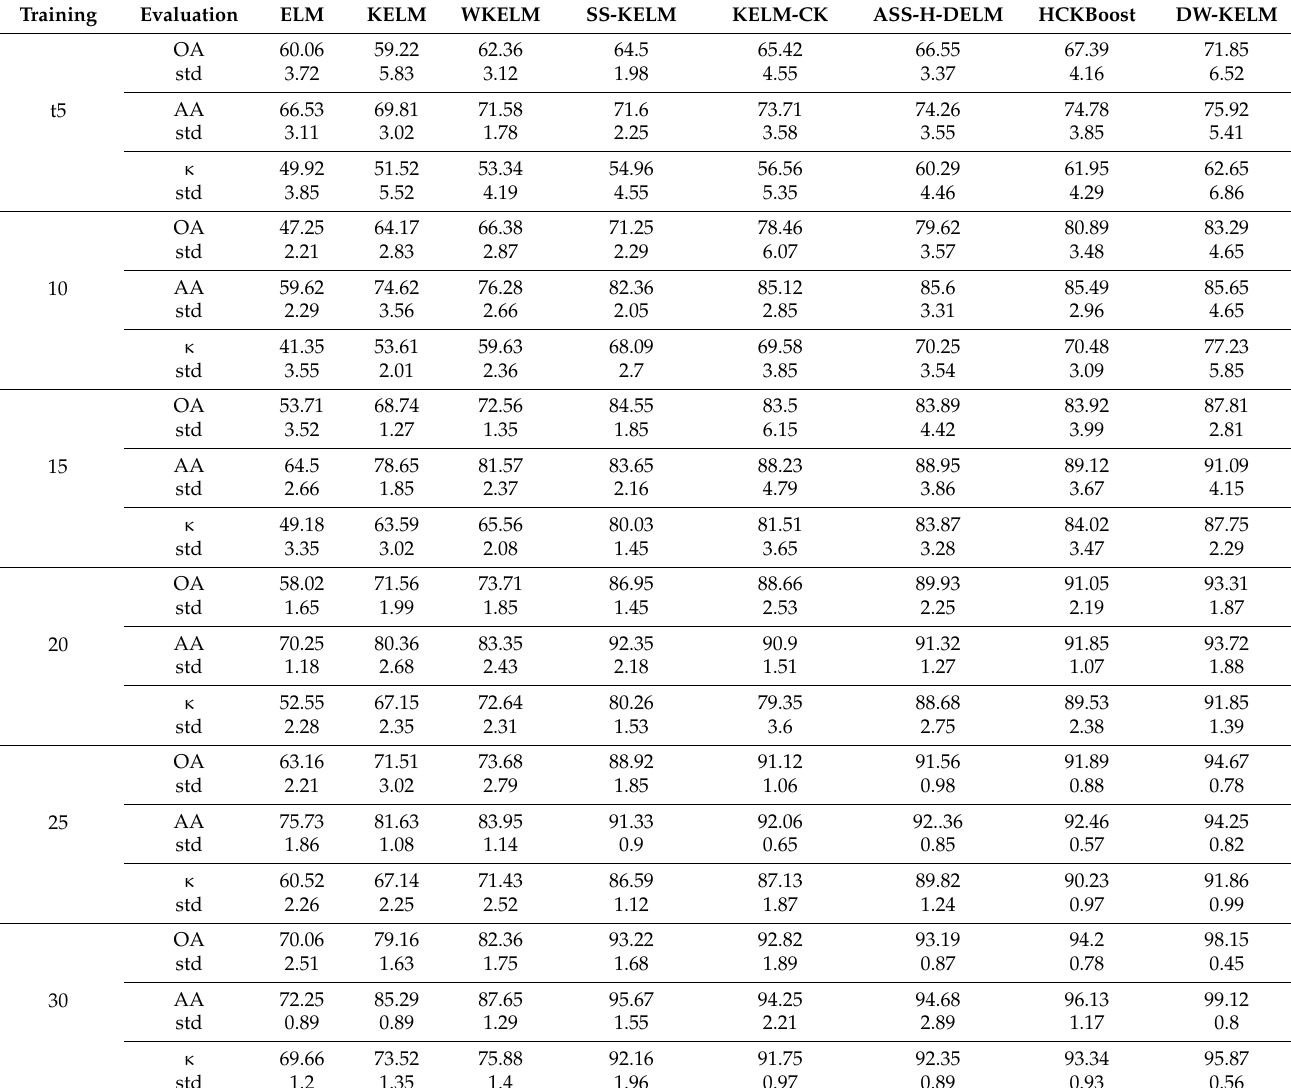
Table 4. Results obtained with different training numbers of labeled samples per class on the University of Pavia data set. Training Evaluation